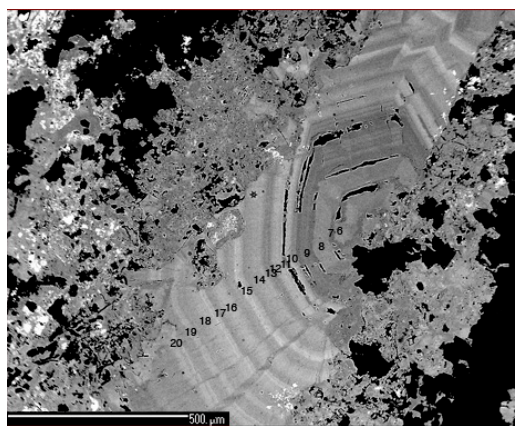
Figure 4. Backscattered scanning electron micrograph of zoned willemite, sample TM06-15. Numbers represent analyses, reported in Table S1.